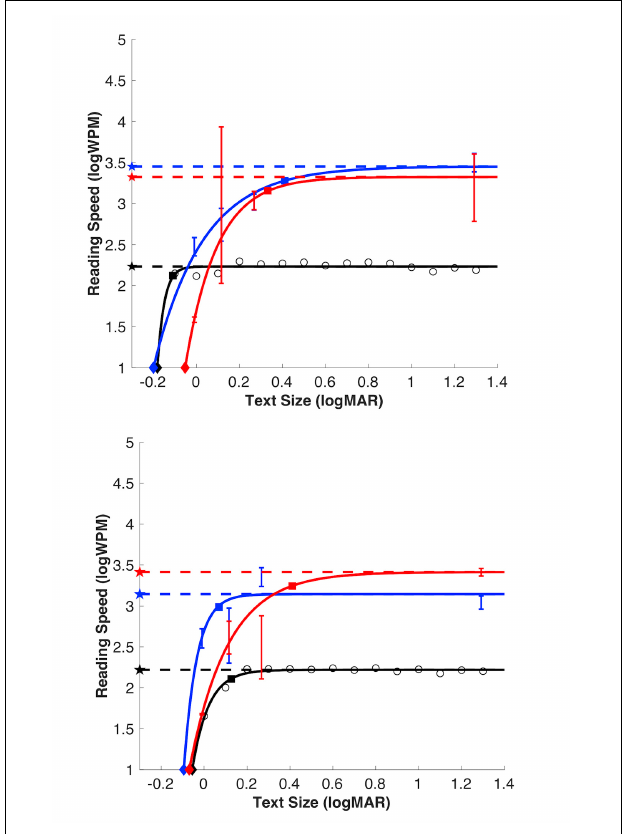
FIGURE 4 | Illustration of the exponential reading functions from two naïve participants for each reading task: True/false (blue), word/non-word (red) and MNREAD (black; raw data as open red circles). Reading estimates for MRS (dashed line with filled stars), CPS (filled squares with dashed lines) and RA (filled diamonds). Threshold duration estimates for true/false and word/non-word tasks plotted as solids lines in their respective colors, error bars show 95% confidence